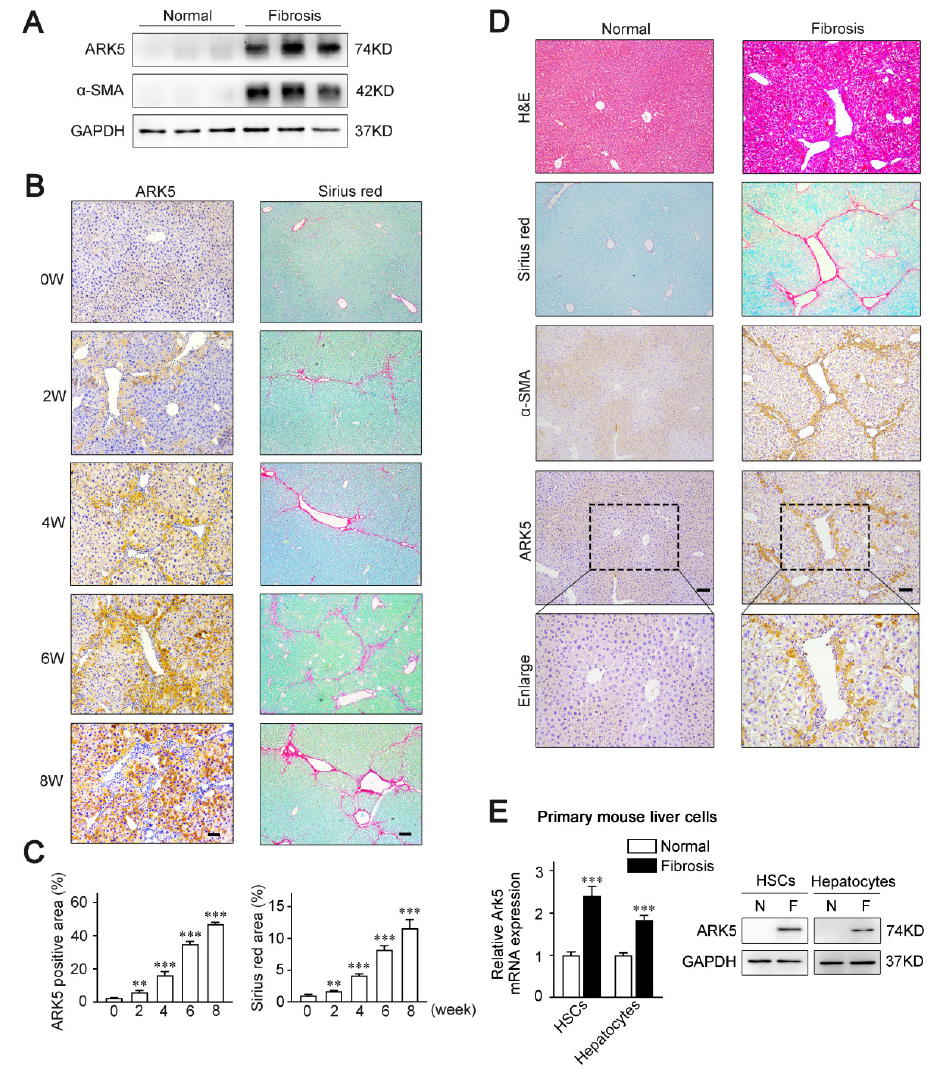
Figure 1. ARK5 associated with liver fibrosis progress and mainly increased in activated hepatic stellate cells and hepatocytes. ( A ) Western blot analysis of ARK5, α -SMA expressions in liver tissues from normal and CCl 4 -treated mice ( n = 3). ( B ) Immunohistochemistry analysis of ARK5 and Sirius red staining in indicated groups of CCl 4 -induced fibrosis models. Scale bar, 100 µ m. ( C ) Quantification of ARK5 immunohistochemistry (Left) and Sirius red staining (Right). ( D ) Hematoxylin-eosin (H&E) staining, Sirius red staining, and immunohistochemistry analysis of α -SMA and ARK5 of serial sections of mouse normal or fibrotic mouse liver tissues. Scale bar, 100 µ m. ( E ) ARK5 mRNA and protein expression in primary mouse HSCs and hepatocytes isolated from normal or CCl 4 -induced mouse fibrotic livers. Mean ± SD ( n = 3 per group), ** p < 0.01, *** p < 0.001 versus normal group. α -SMA, α -smooth muscle actin.